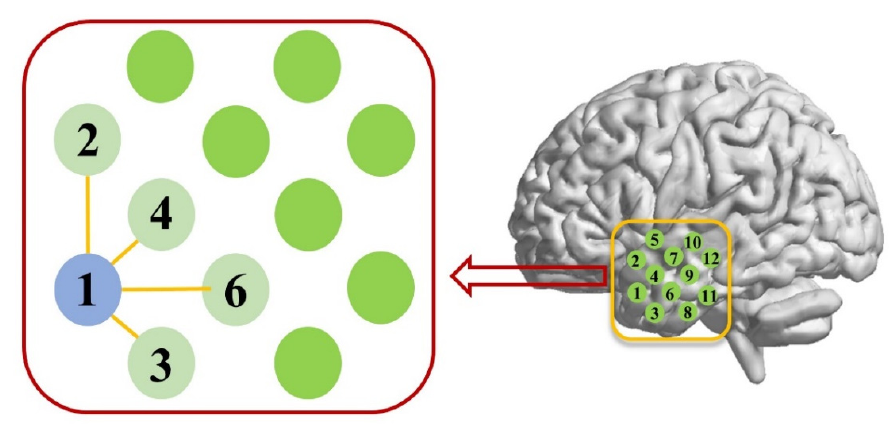
Figure 2. Schematic representation of the short-range RSFC. For example, there are 4 correlation coefficients for channel pairs formed by Channel-1 and its adjacent (distance ≤ 30 mm) channels including Channel-2, 3, 4, and 6. The average of the 4 correlation coefficients indicates the short-range RSFC for Channel-1. The distances between Channel 1 and Channel 2, and Channel 1 and Channel 6 were 30 mm. The distances between Channel 1 and Channel 3, and Channel 1 and Channel 4 were 21 mm.